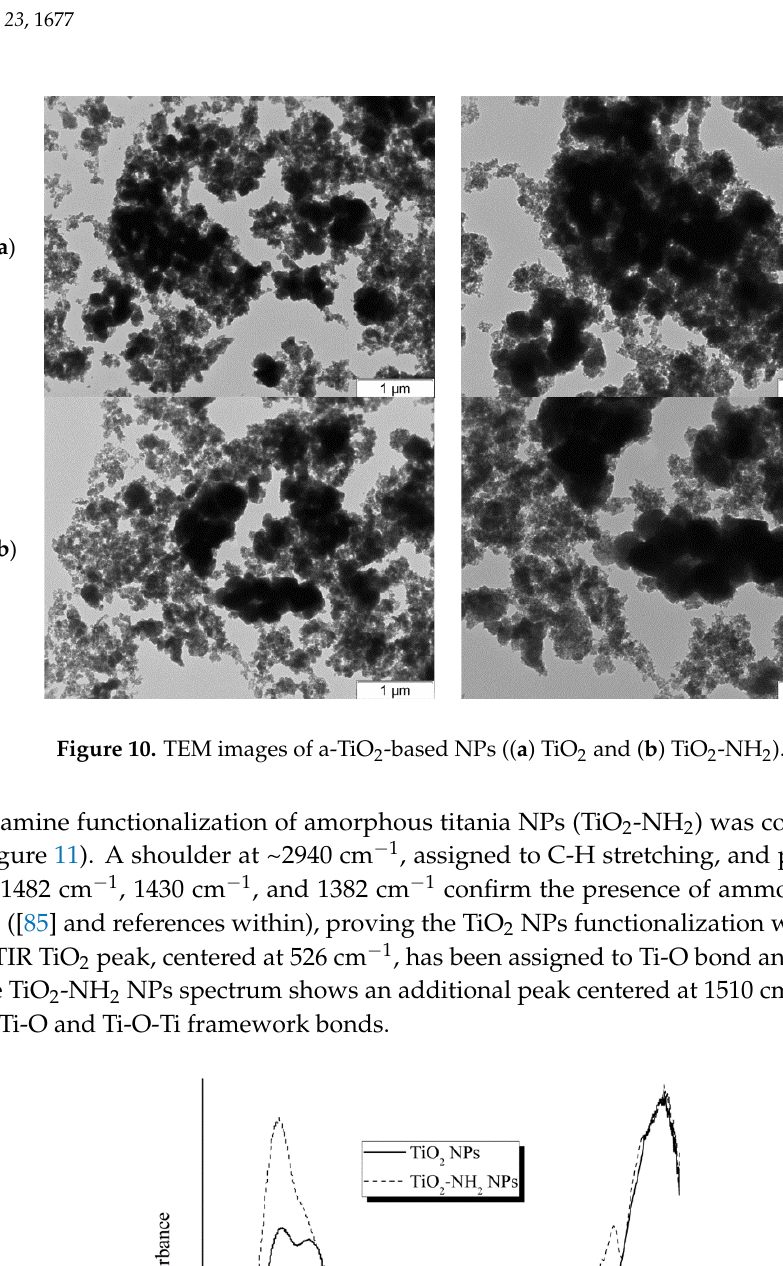
Figure 12. XRD diffractograms of a-TiO 2 -based NPs. The bactericide properties of the a-TiO 2 -based NPs were determined for Escherichia coli strain according to ASTM E 2149 (incubation period of 1 h, at room temperature, under daylight). Results are presented in Table 2, and it can be seen that all a-TiO 2 -based NPs exhibit bactericide efficiency